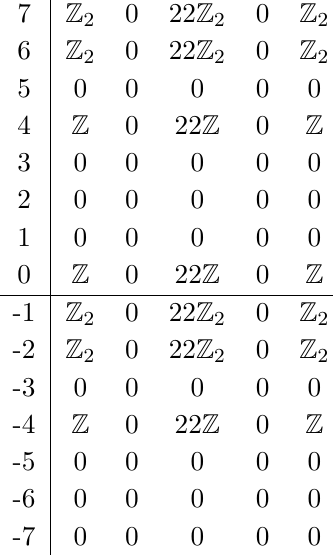
Table 18 . Second (and final) page of the AHSS for the computation of KO − n ( K 3)